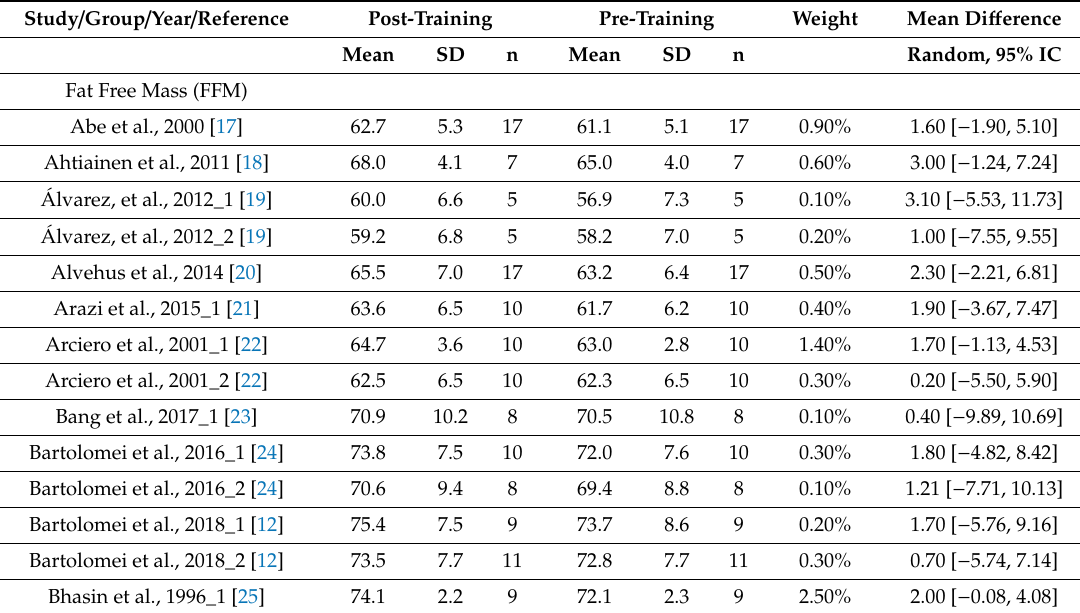
Table 1. Main di ff erences between pre-post study in the main body composition variable considered. The numerical su ffi x after the references indicate the di ff erent subgroup in the same study. See supplemental material for more